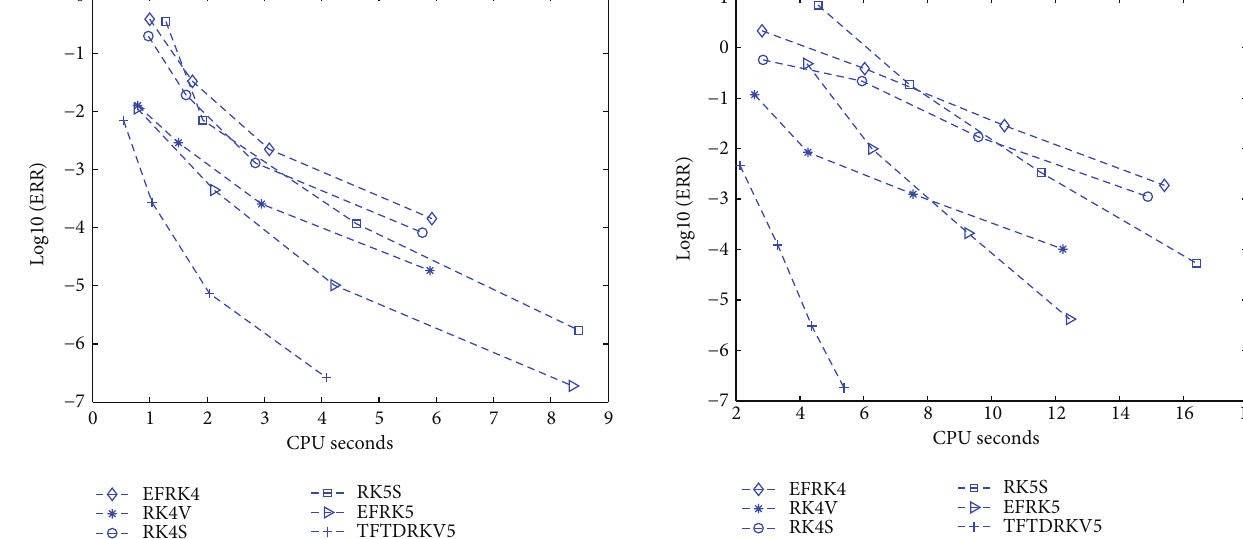
Figure 2: Efficiency curves for Problem 1: 𝐸 = 53.588872 . Figure 3: Efficiency curves for Problem 1: